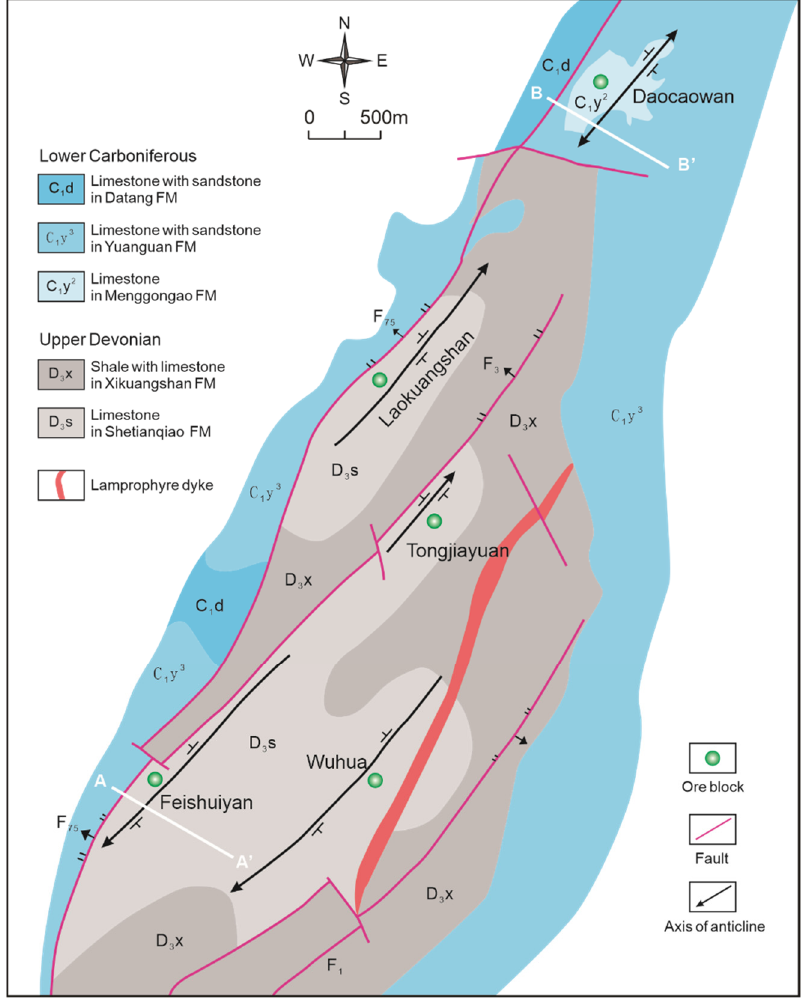
Figure 2. Geological map of the Xikuangshan ore field (Modified from [31]). The Daocaowan Sb deposit is located outside the northern margin of the Xikuangshan Sb deposit.